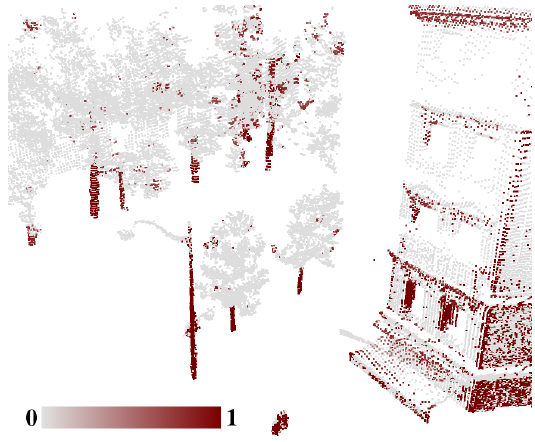
Figure 7: Visualization of the cylindrical descriptor D cyl ( i ) .